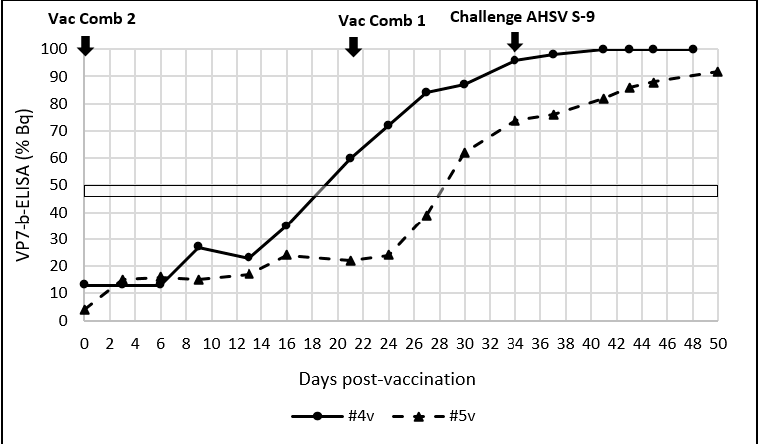
Figure 4. Detection of antibodies by VP7 Blocking-ELISA in vaccinated horses #4v, #5v (Vaccination and infection stages).